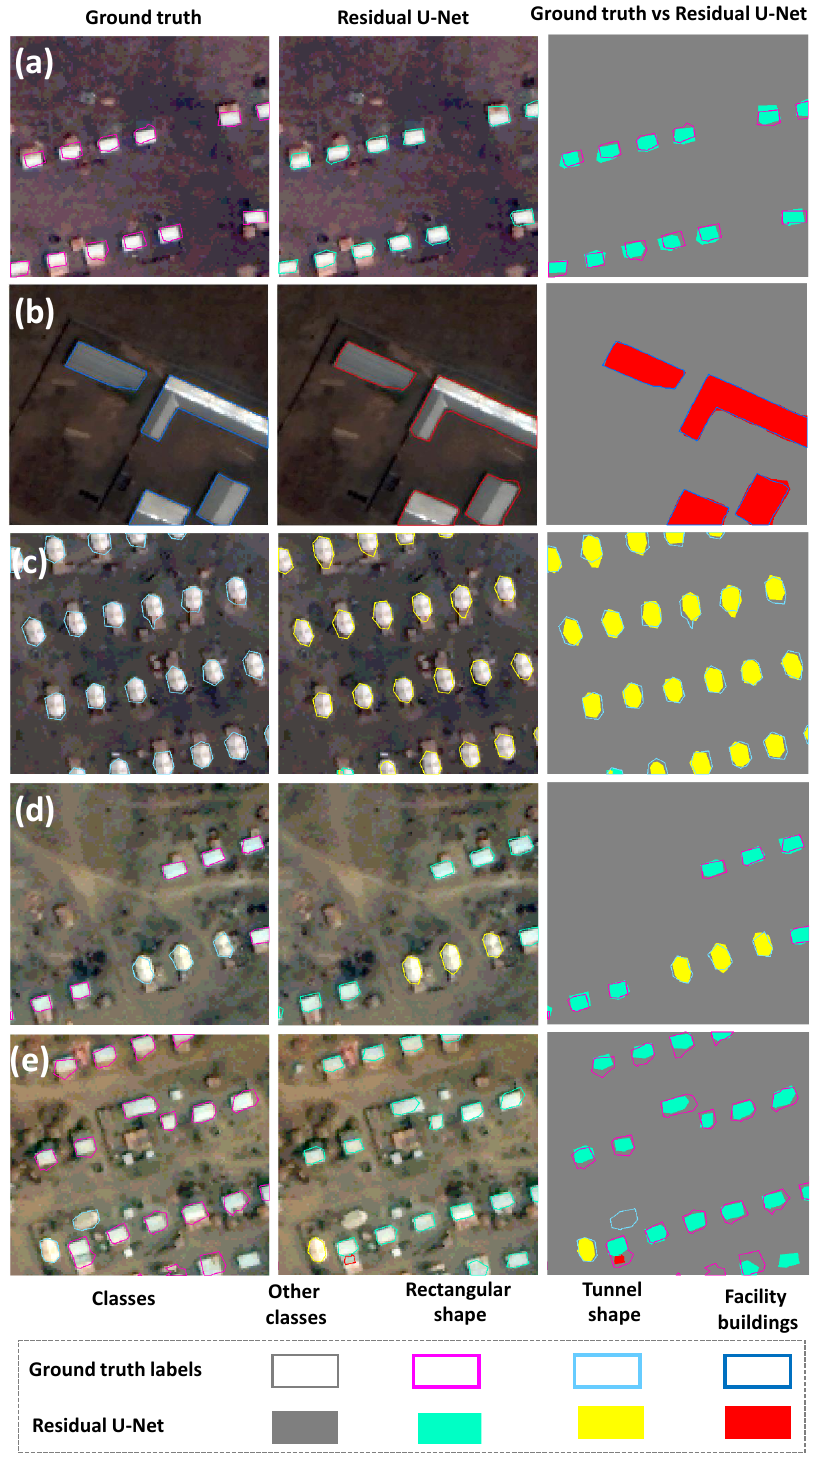
Figure 6. Example classification results on the test set of image patches resulting from residual U-net and comparison with the ground truth labels. The image patches ( a – e ) are selected from the test